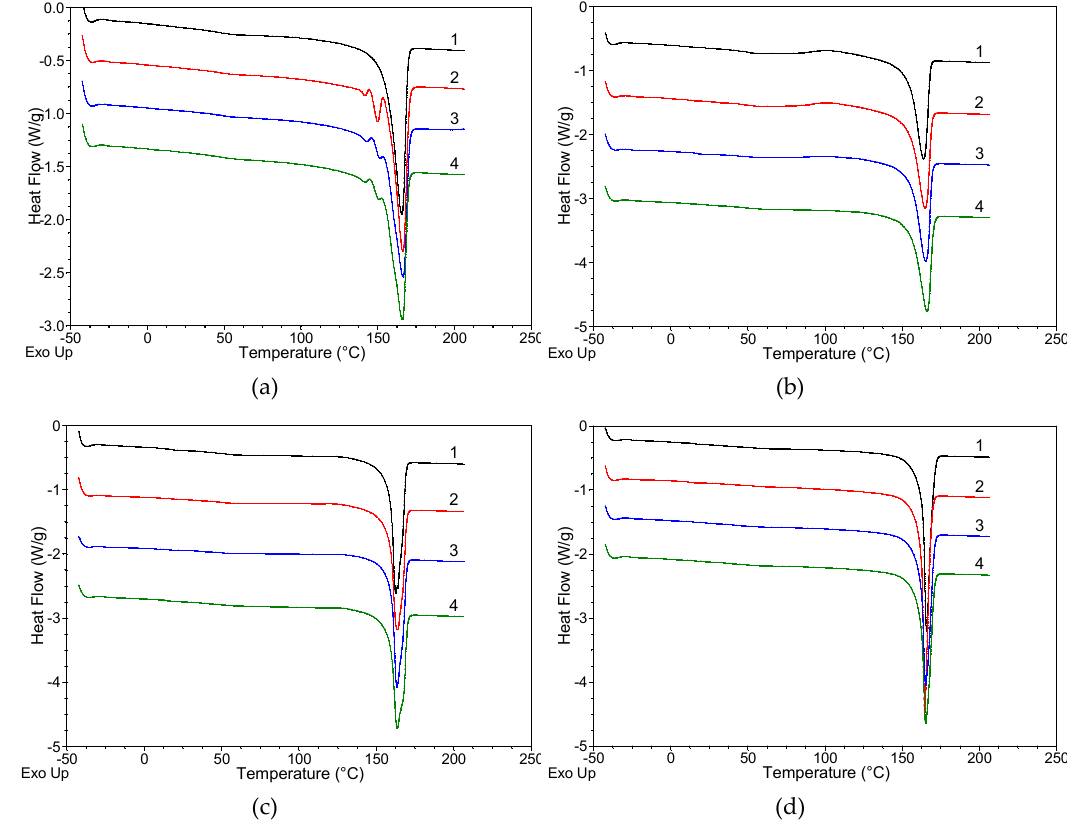
Figure 6. DSC curves for polypropylene fibers: ( a ) gravity spun; fibers taken at ( b ) 50 m/min; ( c ) 200 m/min; ( d ) 800 m/min. In the drawings, black curves (1) refer to fibers of pure polypropylene, while red (2), blue (3), and green (4) curves refer to fibers of iPP with rGO-CP in the amount of 0.1, 0.5, and 1.0 wt.%, respectively.